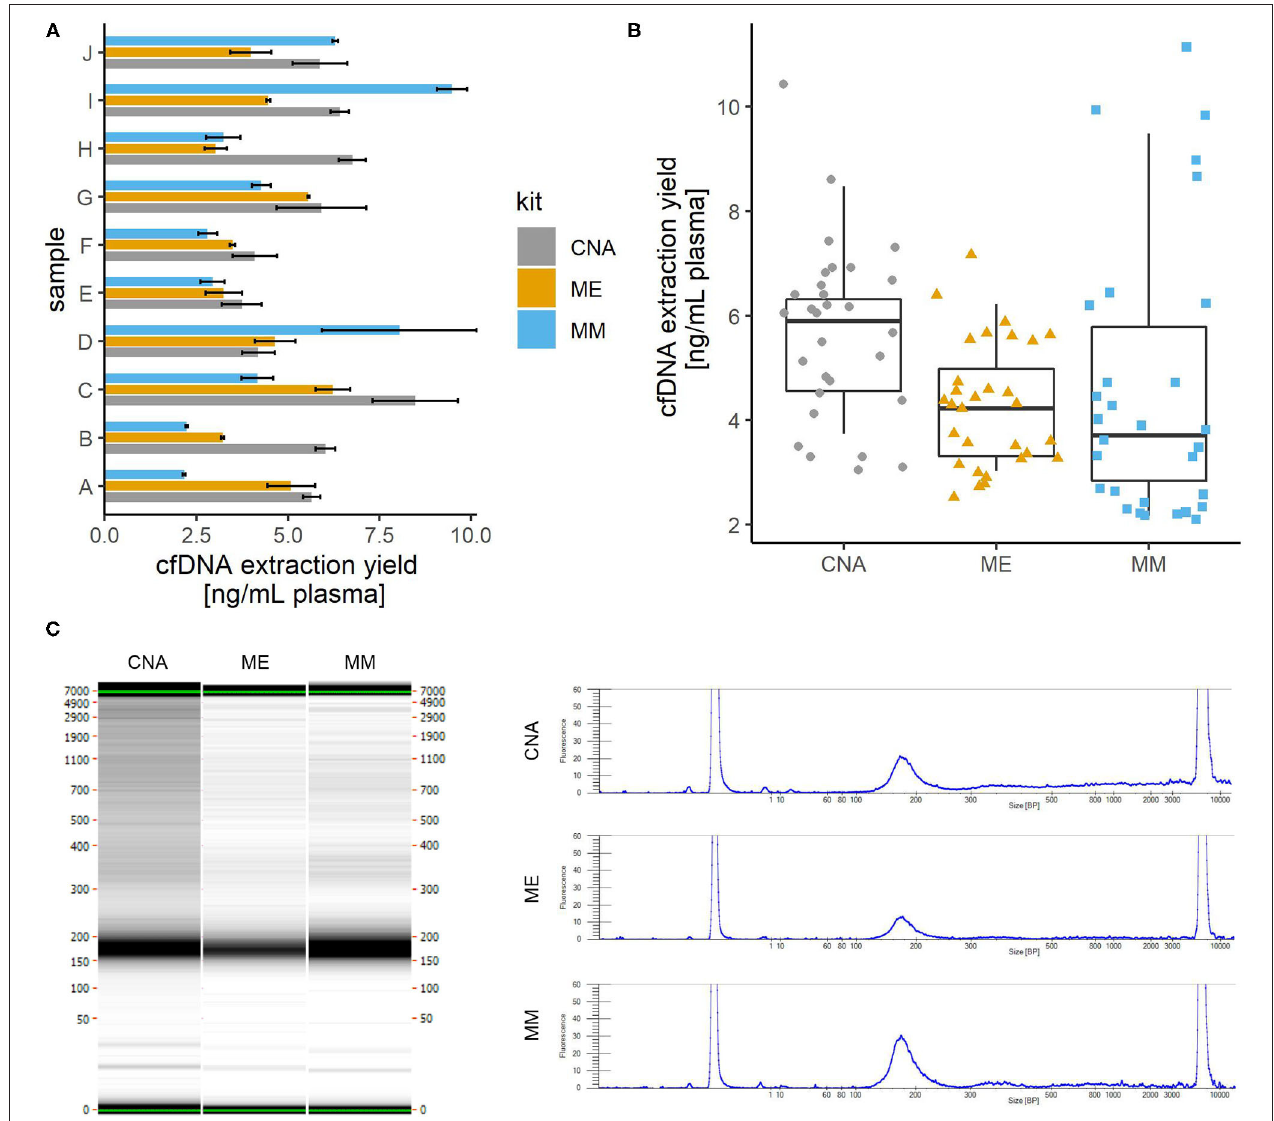
FIGURE 1 | Comparison of cfDNA isolation from plasma using three different commercially available kits. cfDNA was isolated from 1ml of plasma using each kit in three replicates. (A) The average yield for each plasma sample. Error bars show the standard deviation of three replicates. (B) Distribution of yield of cfDNA isolation with three kits. Colored shapes show the individual yields of all samples/replicates and boxplots show the average yields across replicates. No significant differences were observed between the yields obtained with the three kits tested. (C) Comparison of fragment sizes. The left panel shows the capillary electrophoresis gel for one of the three replicates of the same sample extracted with three different commercial kits. On the right, the electropherogram of the same gel shows that the fragment size profile is very comparable between the kits, with a major peak around 170 bp representing mainly the mononucleosomal cfDNA fraction and a minor peak